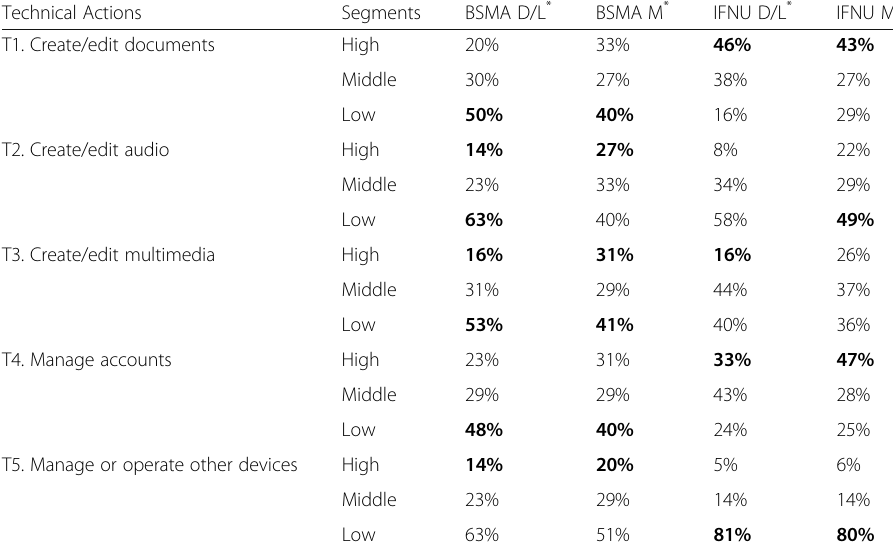
Table 2 Digital readiness segments for technical actions Technical